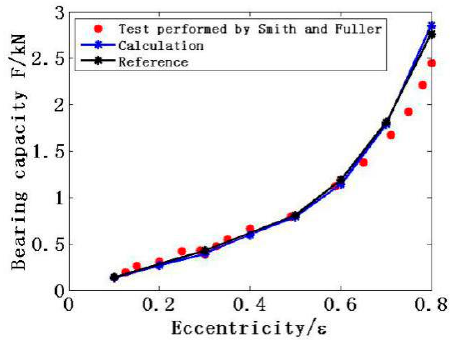
Figure 7. Verification of the bearing capacity of the circular bearing.